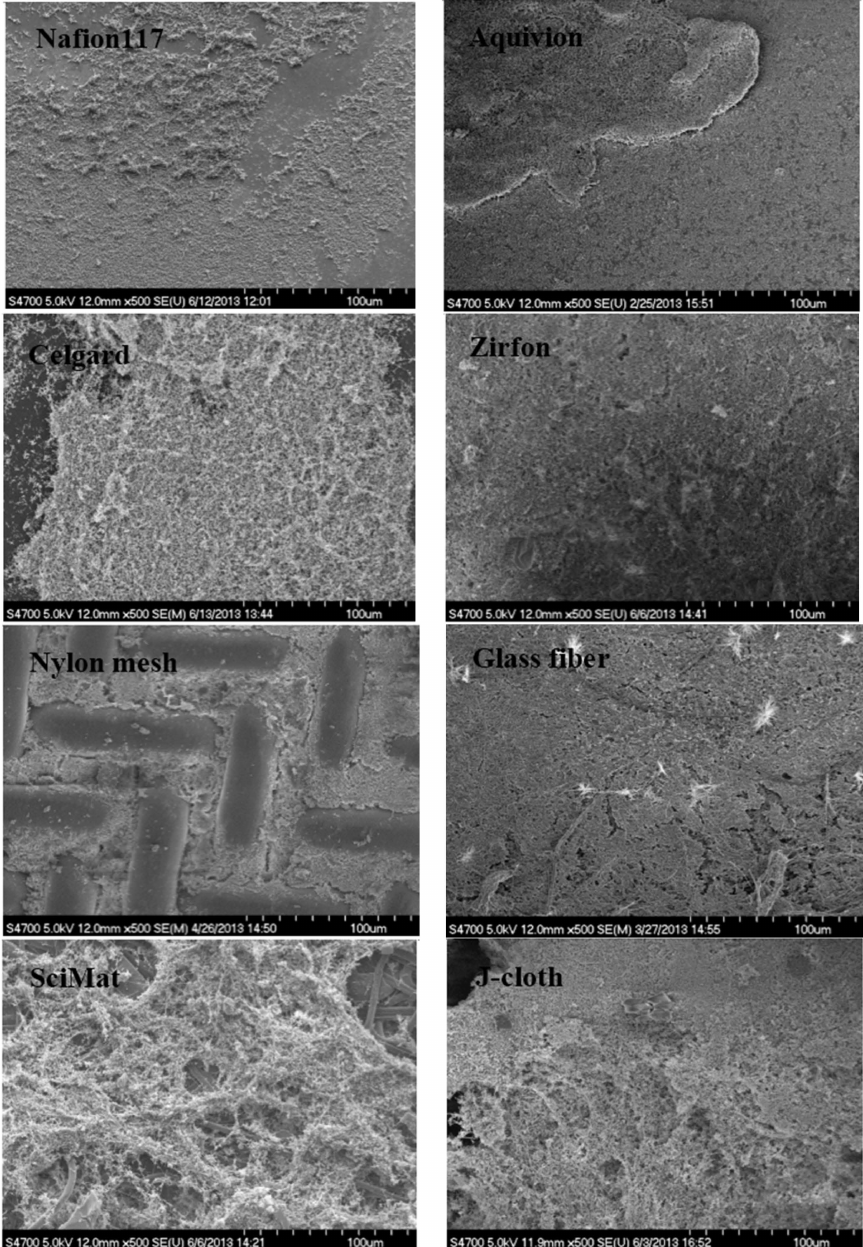
Figure 4. SEM images from the surface of the (bio)fouled (used)